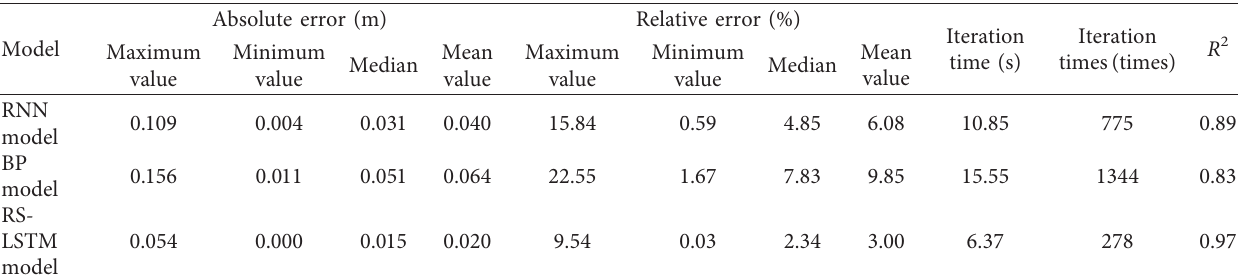
Table 1: Comparison of model prediction